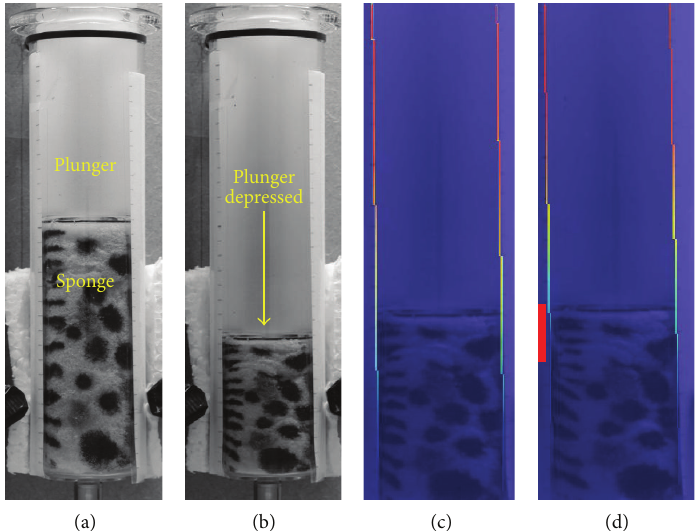
Figure 5: Syringe test object displaying (a) uncompressed sponge, (b) compressed sponge, (c) shear result without adhesive tape, and (d) shear result with adhesive tape (indicated by red